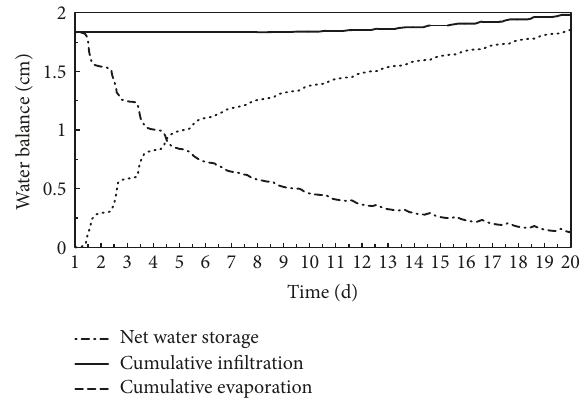
Figure 8: Temporal changes in the accumulation infiltration (solid line) and evaporation (dashed line) as well as the net water storage during the simulation